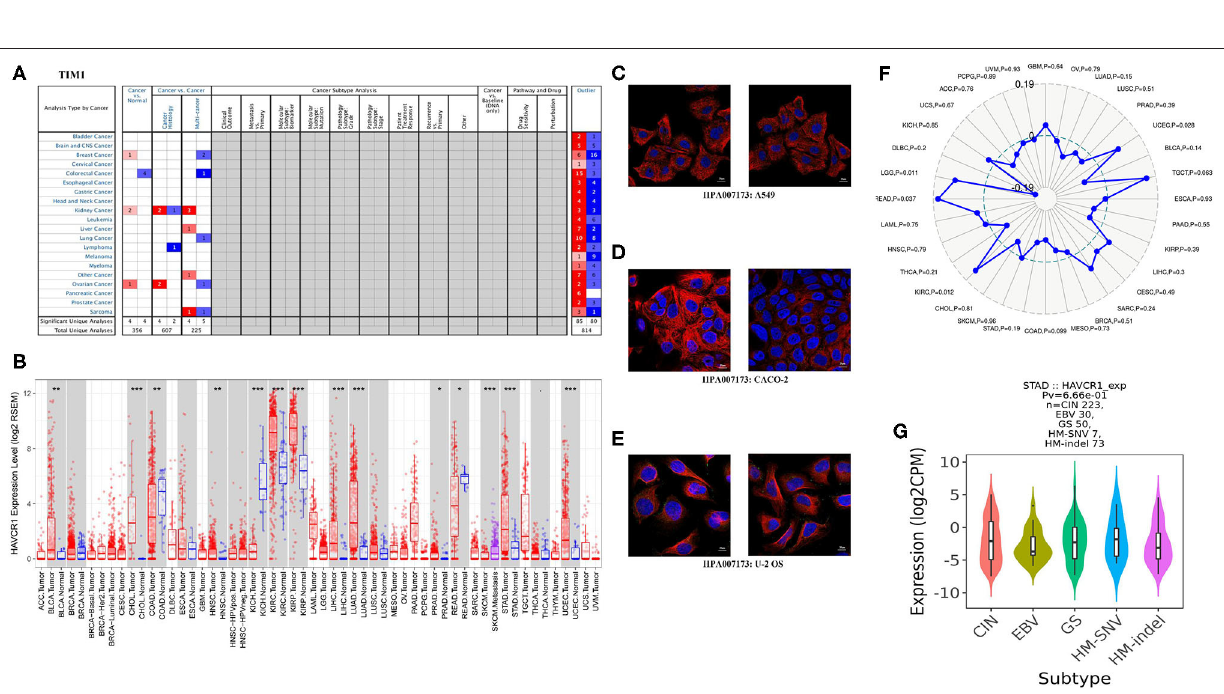
Frontiers in Oncology | www.frontiersin.org